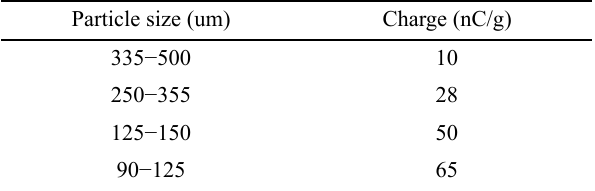
Table 4 Effect of particle size on